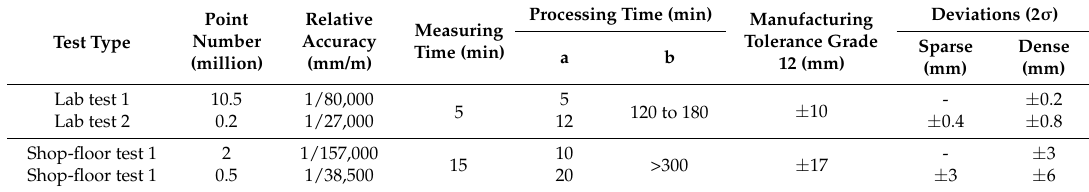
Table 2. Summary and comparison of dense matching techniques for lab and shop-floor